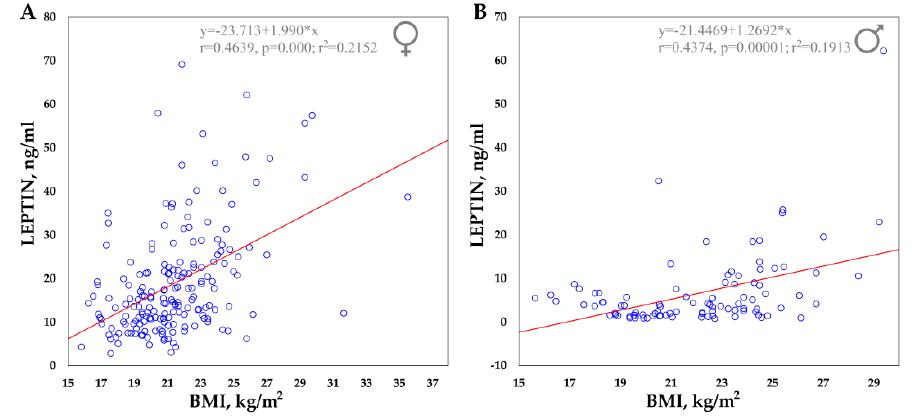
Figure 1. Correlation between serum leptin concentrations and BMI in the Yakut population. ( A ) Females. ( B ) Males. Table 1. Characteristics of study subjects by BMI and gender.